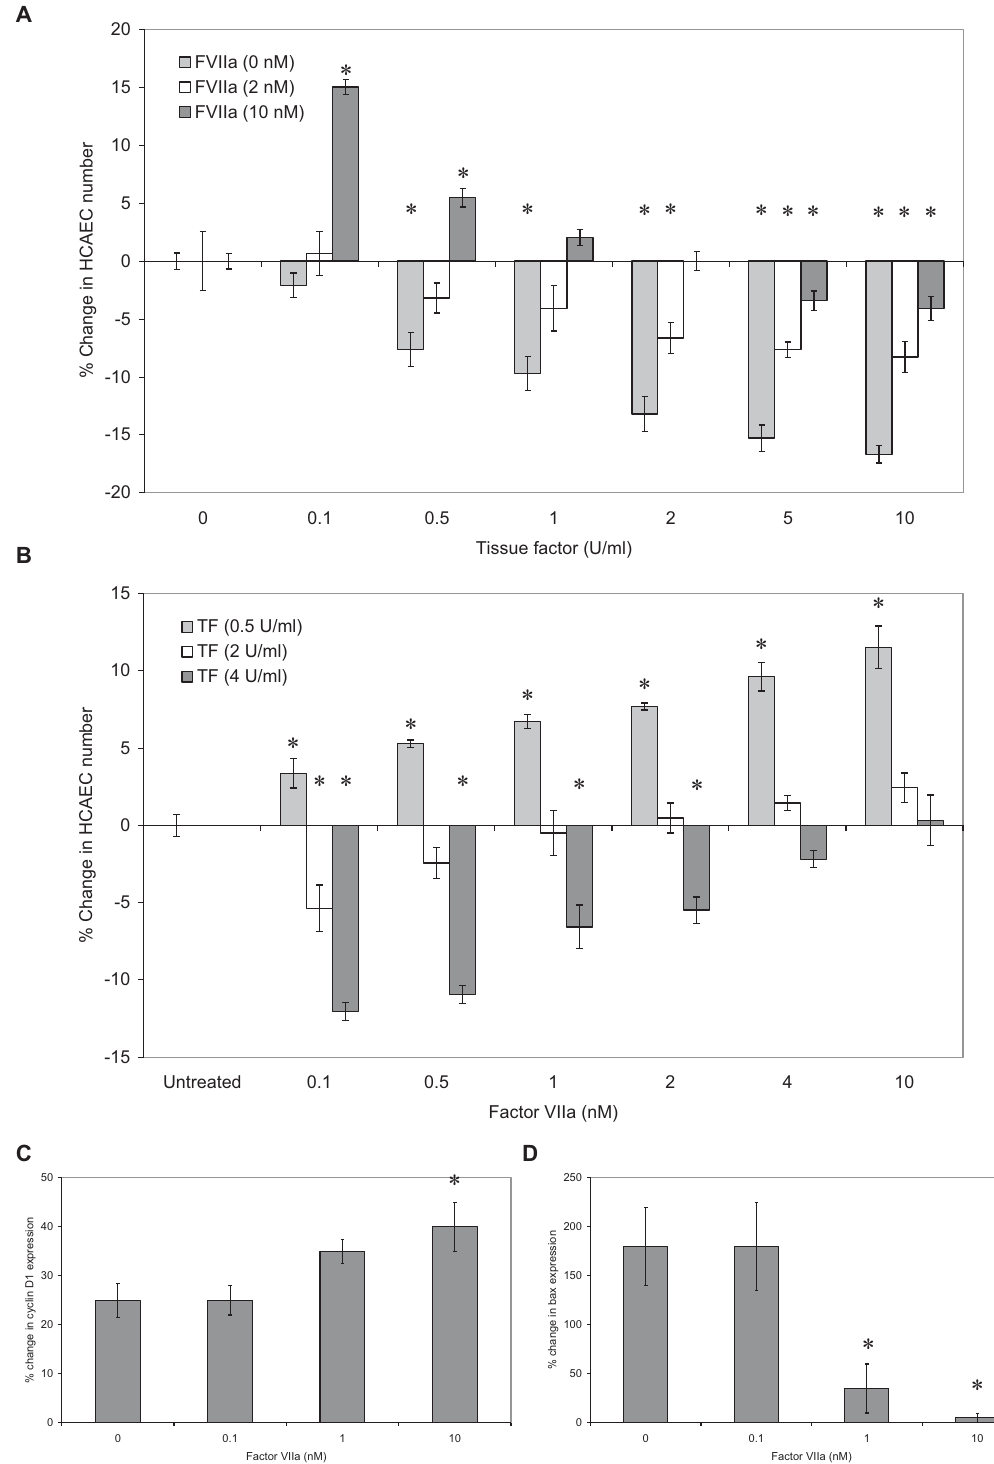
Fig. 3 Examination of the effect ofdifferent ratios of fVIIa:TF on HCAEC cell numbers. ( A ) HCAECs (2 (cid:1) 10 4 ) were incubated for 24 hours with a range of recombinanthumanTF(Innovinthromboplastinreagent)atarangeof0 – 10U/mL(1U/mL ¼ 1.3ng/mL),inthepresenceorabsenceofpuri fi edfVIIa(0 – 10 nM).Cellnumbersweredeterminedbycrystalvioletstainingassayandpercentagechangeincellnumberscalculated( n ¼ 5; (cid:4) ¼ p < 0.05vs.theuntreated sample).( B )HCAECs(2 (cid:1) 10 4 )werealsoincubatedfor24hourswitharangeofconcentrationsofpuri fi edfVIIa(0.1 –